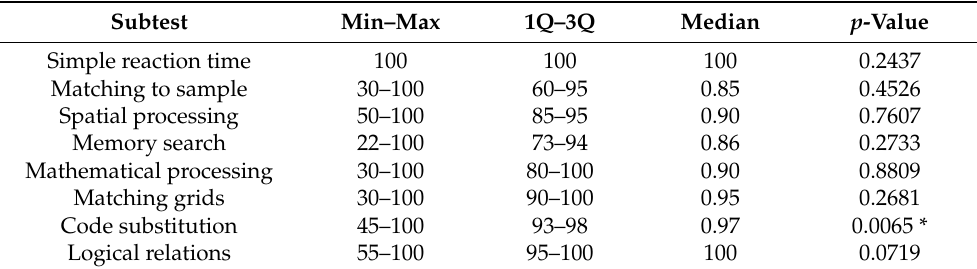
Table 4. Percentage of correct answers by cSLE patients in each subtest of the Ped-ANAM battery and comparison with healthy controls.